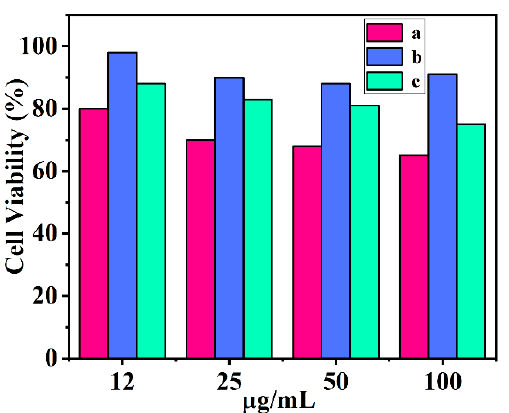
Figure 6. Cytotoxicity of UCNPs ( a ), R-TiO 2 ( b ), and UCNPs@R-TiO 2 nanocomposite ( c ) in HEK 293 cells.